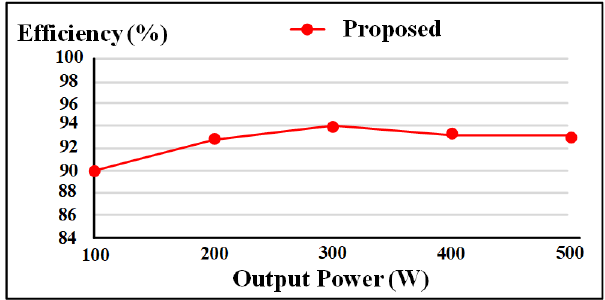
Figure 21. Efficiency curve under step-down